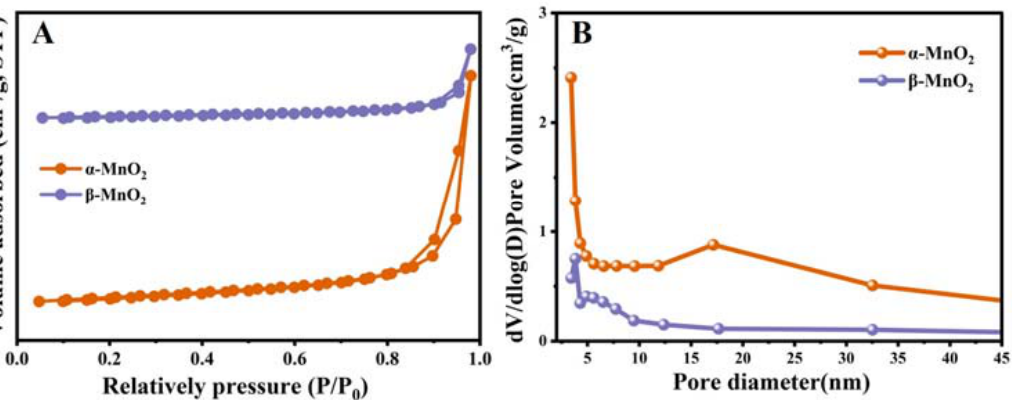
Figure 4. N 2 adsorption-desorption isotherm plots ( A ) and pore distributions ( B ) of α -MnO 2 and β - MnO 2 .